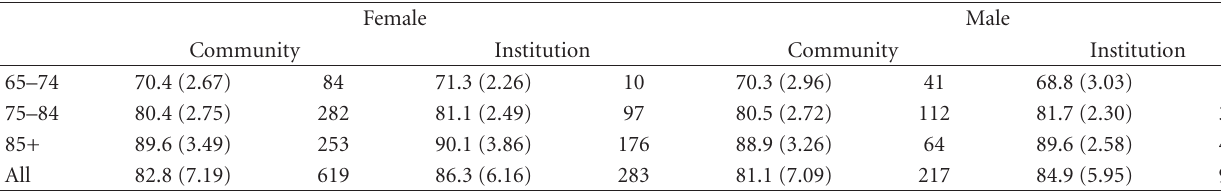
Table 1: Mean age (SD) and hip fracture number of the di ff erent age bands.